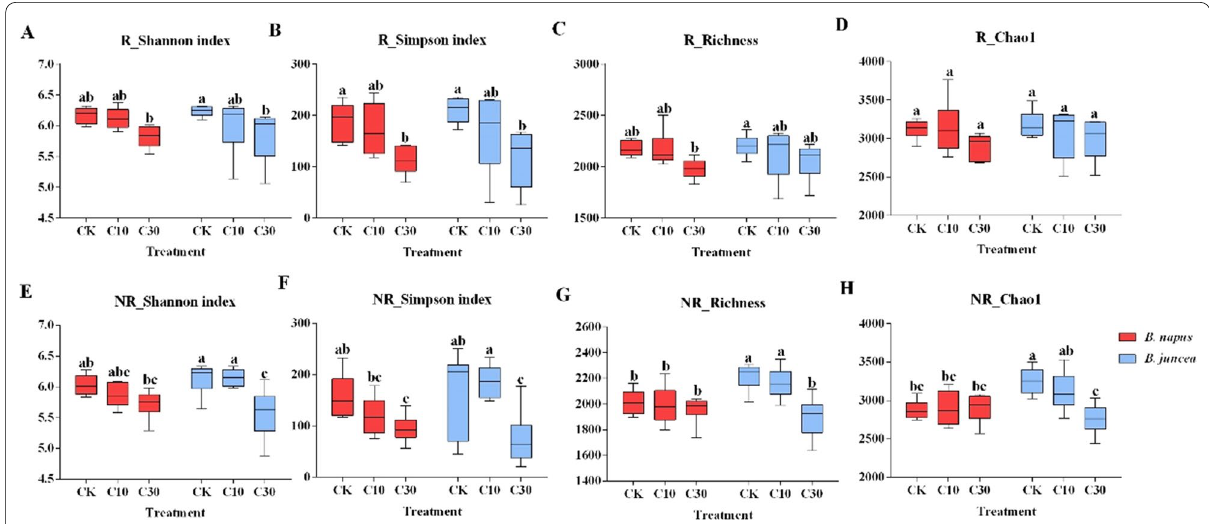
Fig. 3 The effect of Cd on α-diversity of soil bacterial communities. A Shannon index; B Inv_Simpson index; C Richness; D Chao1 of rhizosphere bacterial communities under different cadmium treatment; E Shannon index; F Inv_Simpson index; G Richness; H Chao1 of bulk soil bacterial communities under different cadmium treatment; Means with different small letters are significantly different from one another under the different cadmium concentration treatments, and different rapeseed types ( P <